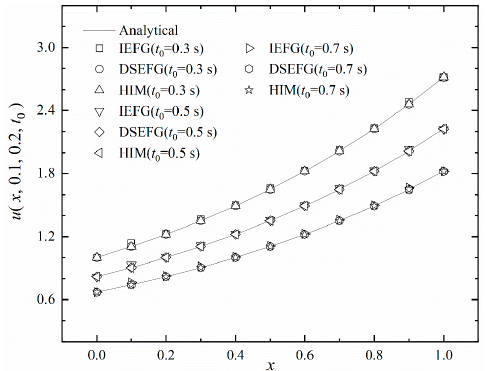
Figure 5. Calculation results along x -axis when t 0 is